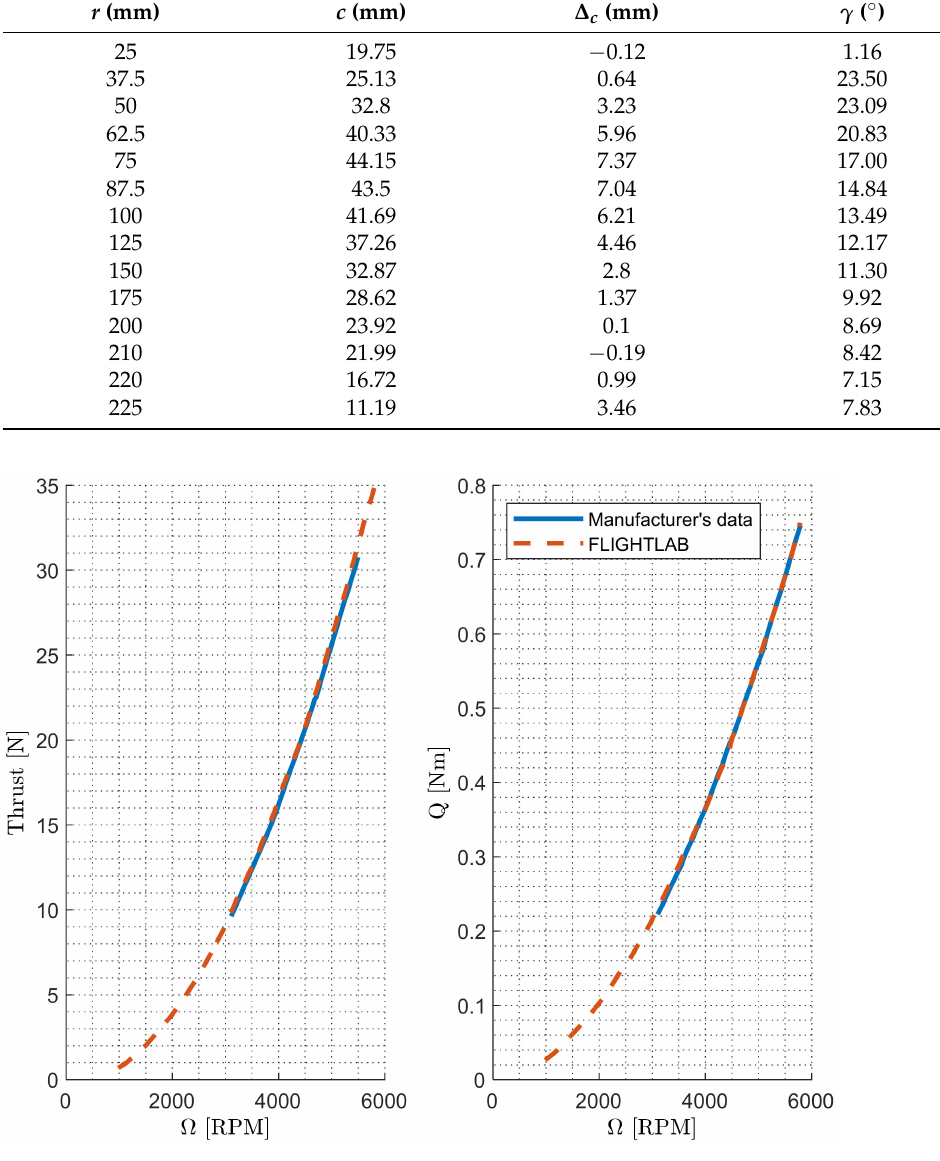
Figure 5. Modeled and manufacturer thrust and torque comparison for hover